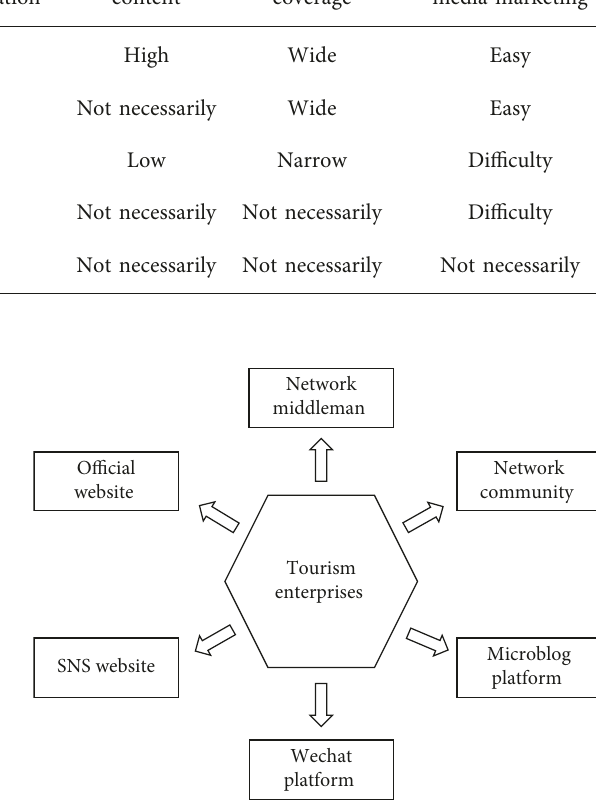
Figure 3: New media marketing channels of tourism enterprises.